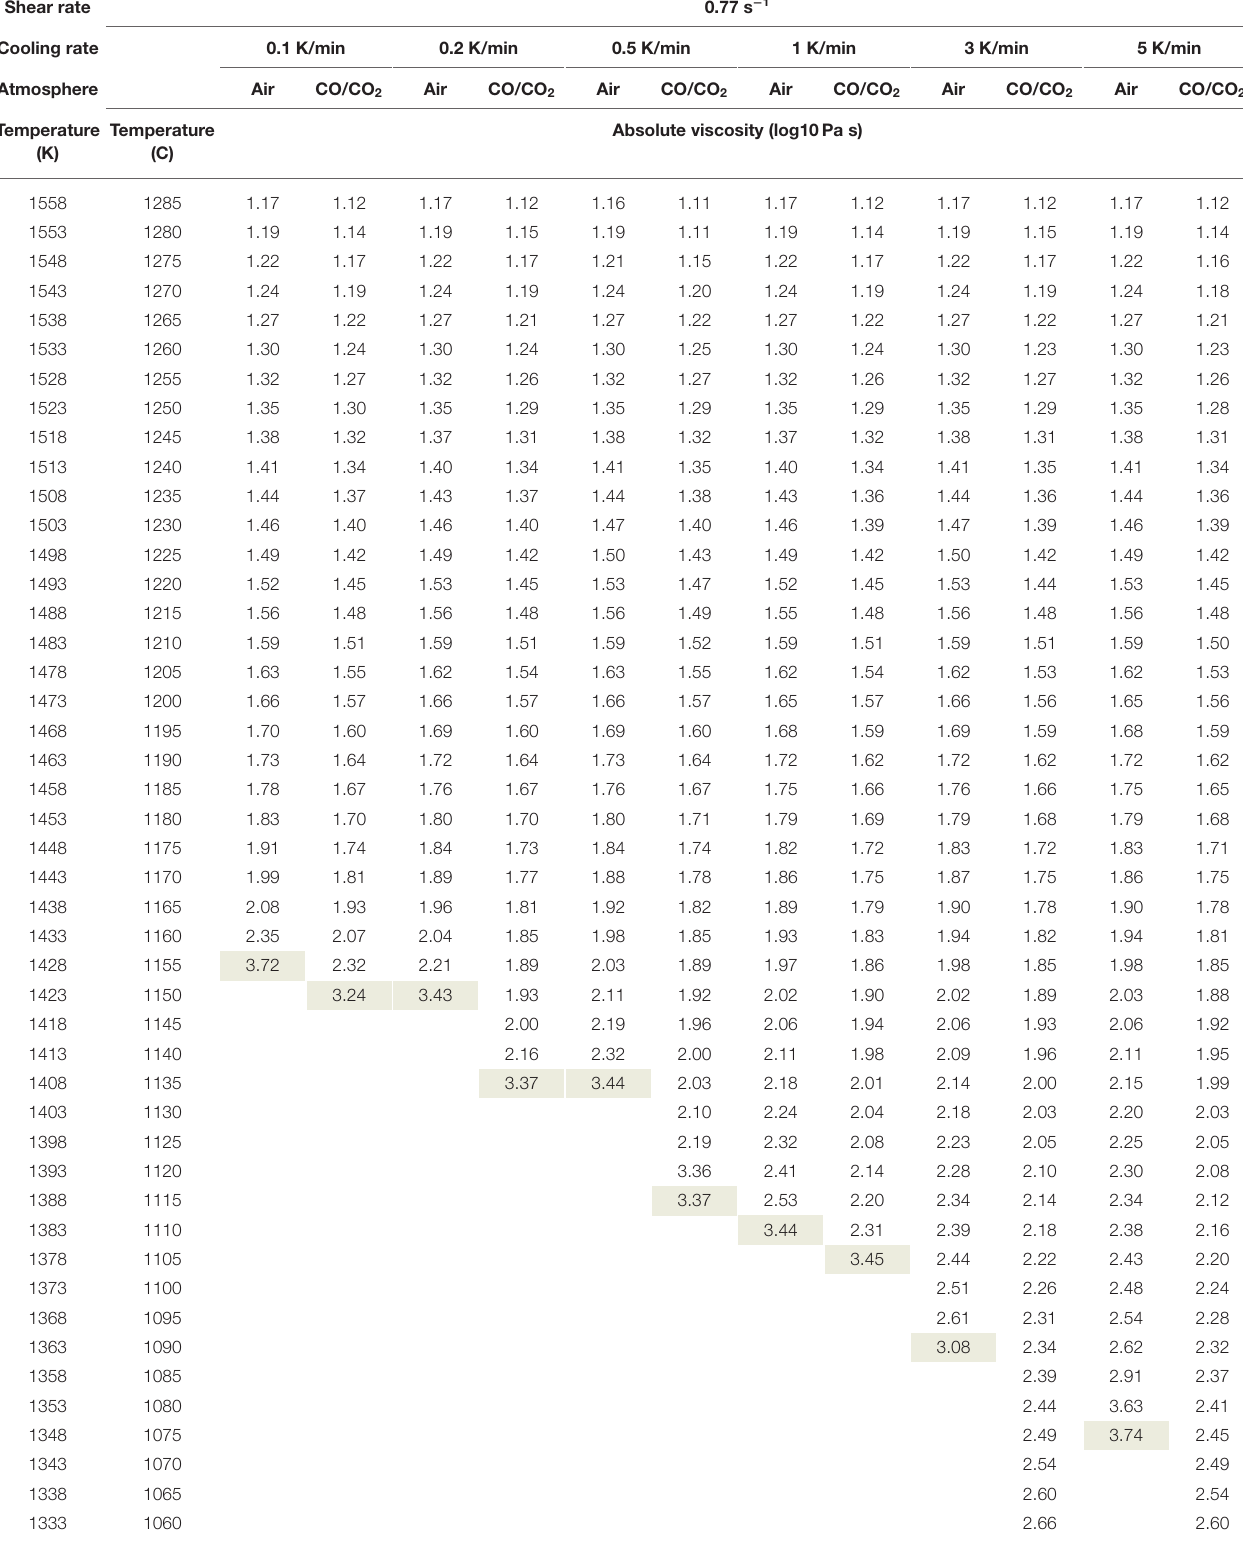
TABLE 3 | Summary of absolute viscosity measurements of all experiments. Shear rate Cooling